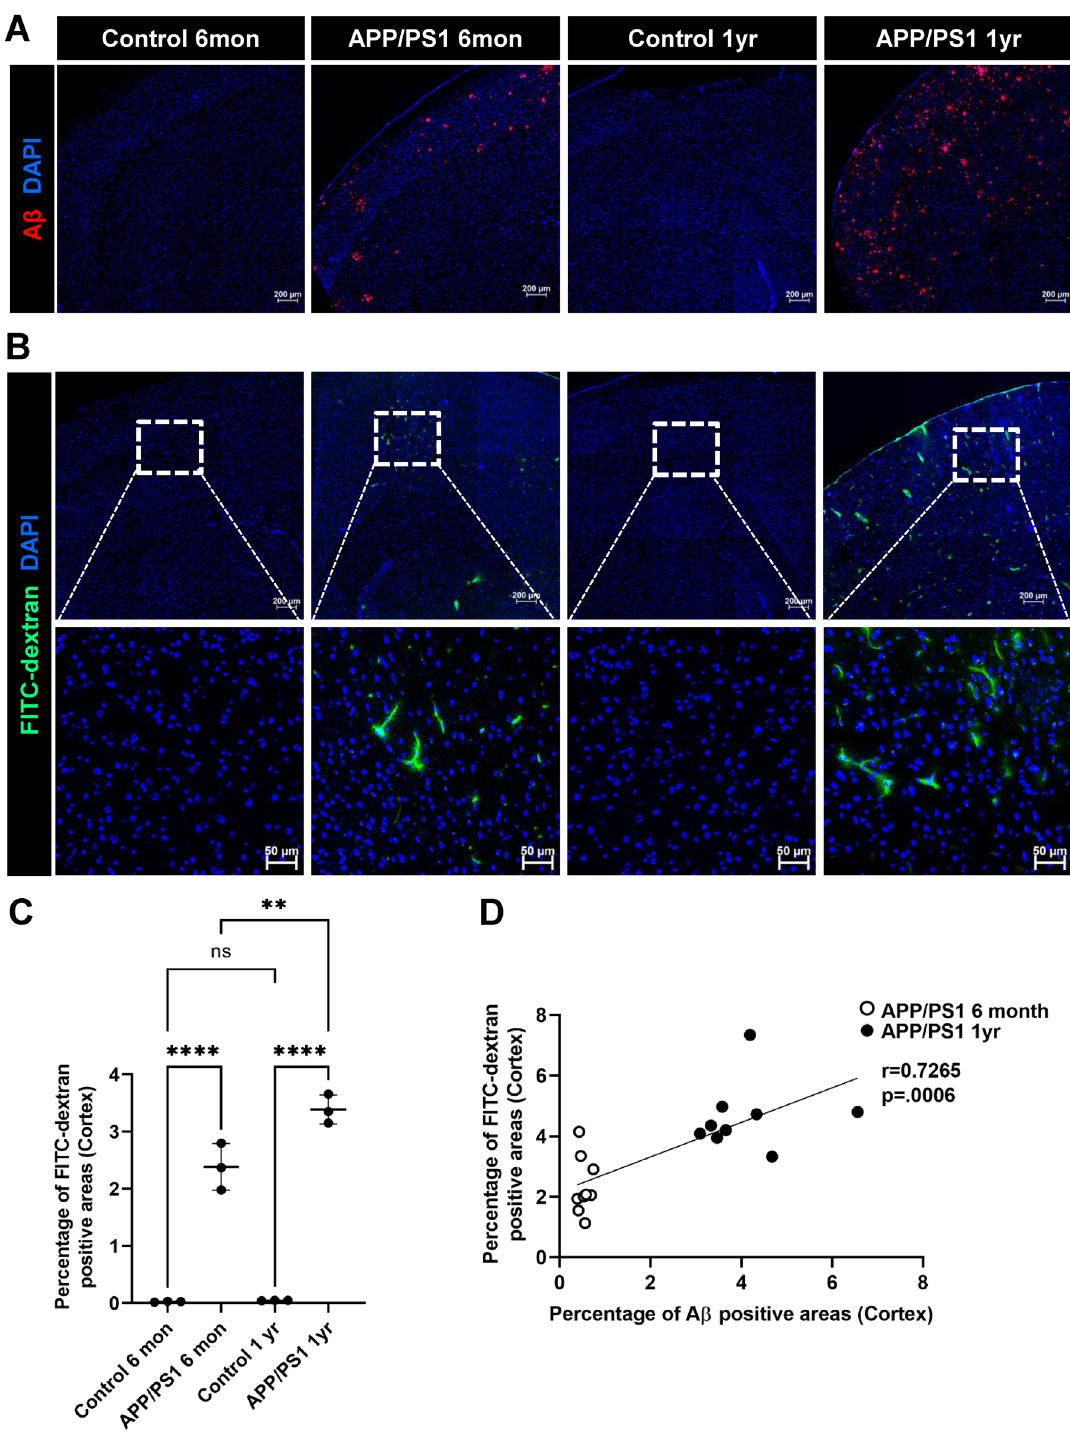
Figure 1. Blood–brain barrier leakiness and Aβ deposition in the cortex of APP/PS1 female mice. Control female age-matched and APP/PS1 female mice were analyzed at ages of 6 months and 1 year old for amyloid plaque by staining with antibody against Aβ (red) and BBB permeability was assessed by FITC-dextran leakage (green) in the brain parenchyma. Low-magnification representative images of coronal sections of the brain cortex for Aβ ( A ) and of FITC-dextran leakage ( B ). The ROI is outlined with a white box and subsequent images are given at higher magnification of tissue corresponding to the ROIs for controls and transgenic AD mice. Nuclei were counterstained using DAPI. Experiments were repeated at least three times with similar results. The most BBB leakage is observed in the 1 year old APP/PS1 female mice. Scale bars, 200 μm and 50 μm respectively. ( C ) Quantification of FITC-dextran leakage in the cortex of the above groups. A significant increase in BBB permeability occurs in 1 year old APP/PS1 female mice compared to 6-month- old transgenic mice. Data are represented as means and SD for three mice for each group and analyzed by one-way ANOVA followed by Tukey’s multiple comparisons test. ** p = 0.0041, **** p = 0.0001, ns non-significant. ( D ) Correlation of Aβ deposition and FITC-dextran leak in 6 months old and 1 year old APP/PS1 female mice. FITC-dextran leakage was positively correlated with age-dependent Aβ accumulation in the cortex. Correlation coefficients and p value are indicated. r Pearson’s coefficient; p